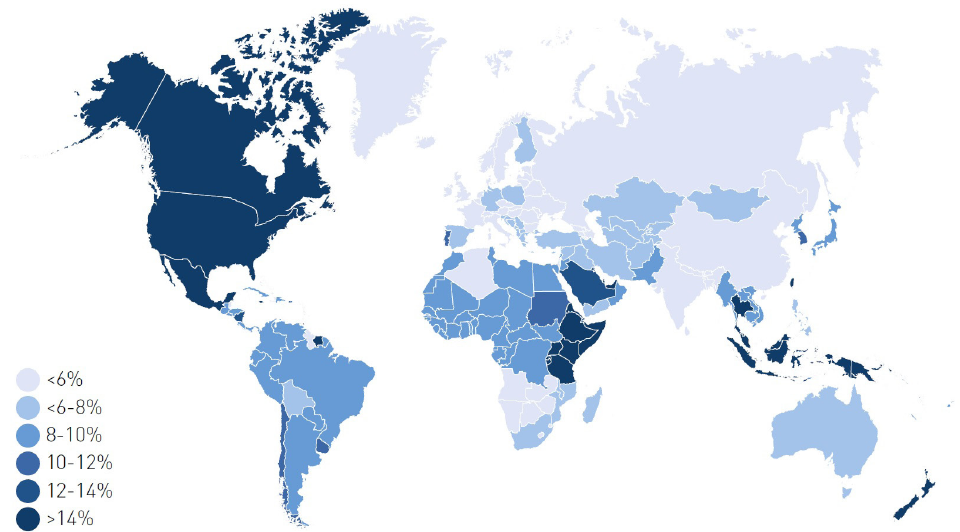
Fig. 1. Age-adjusted prevalence (%) of impaired glucose tolerance (20-79 years), 2017 (ref. 18